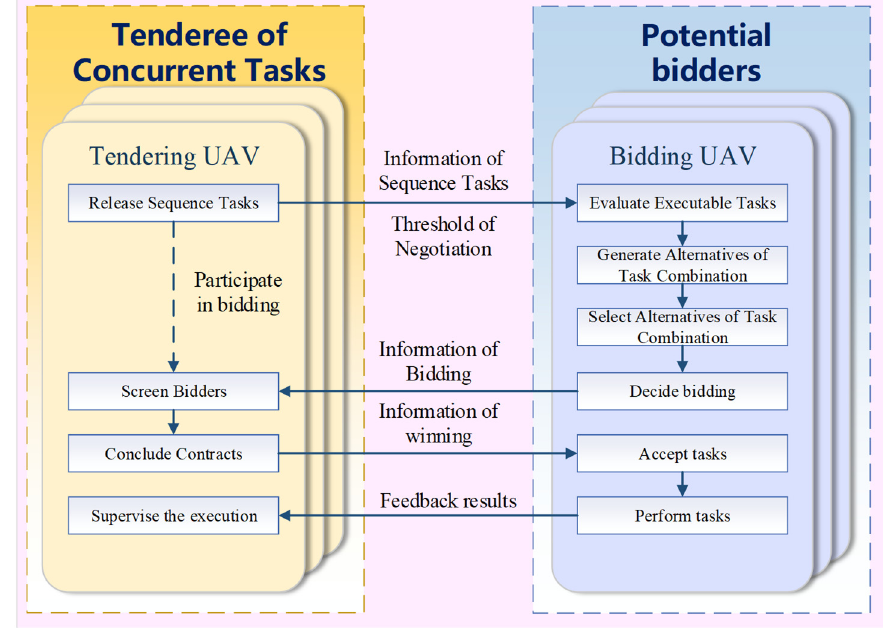
Figure 3. The process of task assignments based on extended CNP.